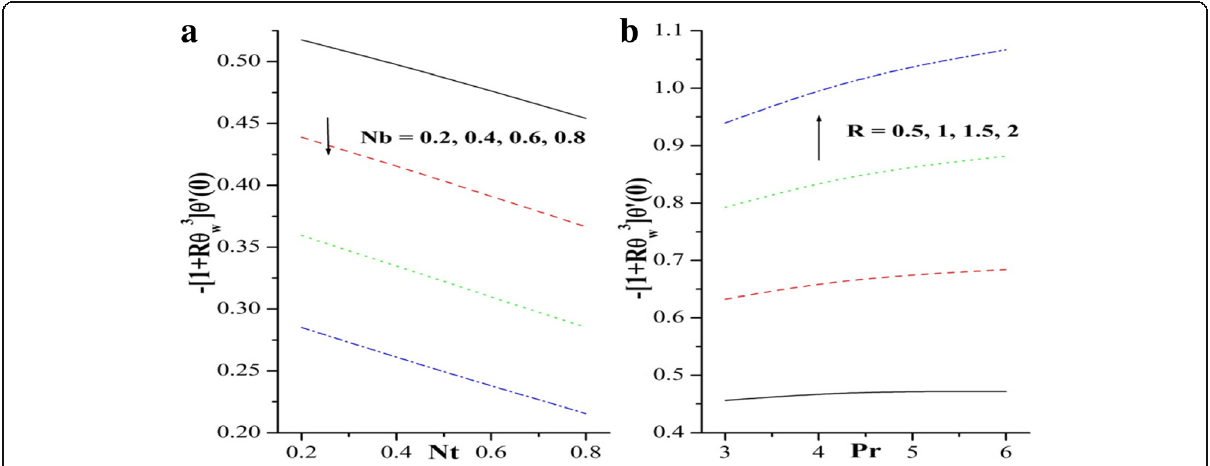
Fig. 18 a , b Influence of Nt and Pr with the various values of Nb and R on Nusselt number, respectively